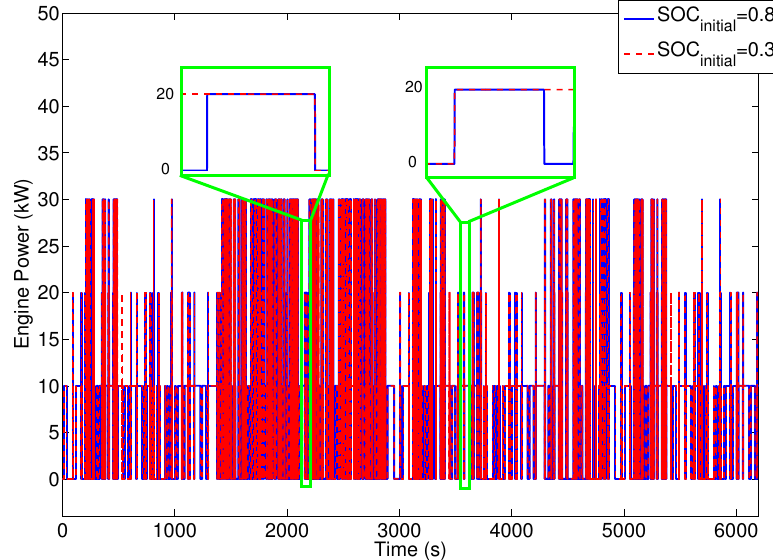
Figure 17. The RCCI engine power pattern in the SHEV for two initial SOC operating conditions (EMC: 3-mode DP).